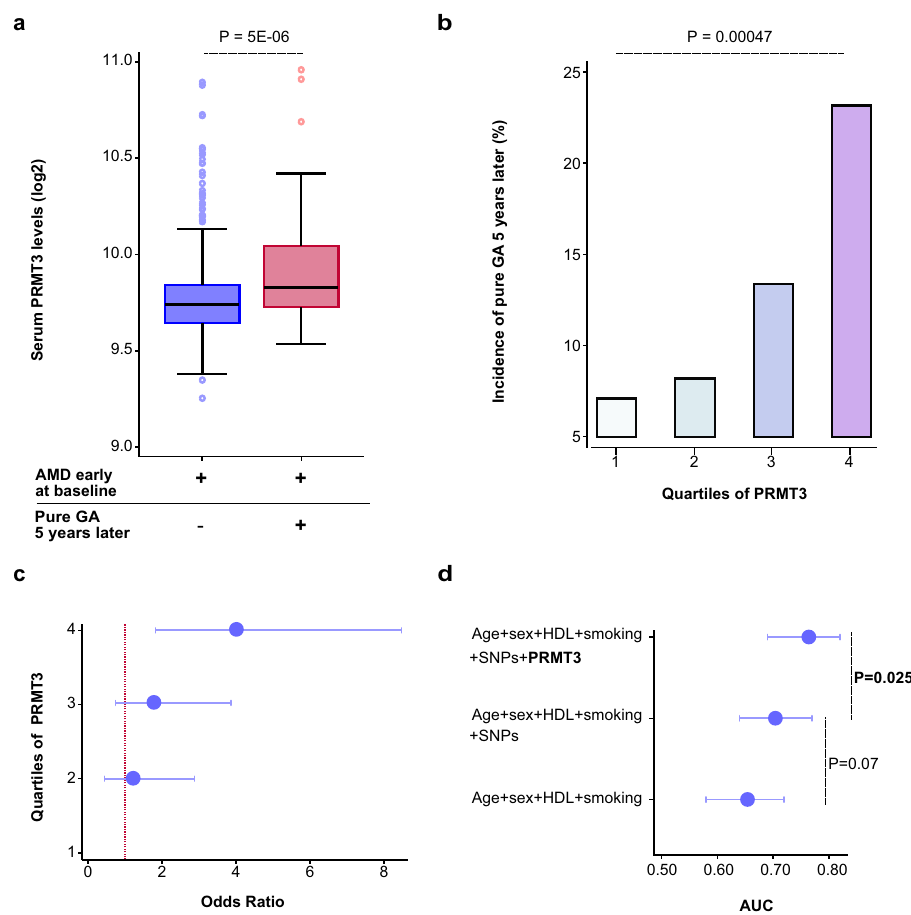
Fig. 3 PRMT3 is a novel biomarker for the progression of geographic atrophy. a Boxplot depicting the distribution of PRMT3 by progression status on a log2 scale. The blue box represents individuals ( n = 428) who had early-stage AMD (de fi nition by Jonasson et al. 23 ) at baseline and after a fi ve-year follow-up, while the red box represents subjects ( n = 62) who progressed from early-stage AMD to pure GA. The boxplot indicates median value, 25th and 75th percentiles. Whiskers extend to smallest/largest value no further than 1.5× interquartile range with outliers being shown. The highlighted P -value is two-sided, obtained from age and sex-adjusted logistic regression analysis. b The observed percentage incidence of pure GA at fi ve-year follow-up ( y -axis), as represented by PRMT3 quartiles ( x -axis), was assessed using an age and sex-adjusted logistic model. The P -value shown is two-sided. c Age and sex- adjusted odds ratios (OR) from a logistic regression model for progression to pure GA after a fi ve-year follow-up by PRMT3 quartiles (1st quartile as reference) (F-test P = 0.001, two-sided). The error bars for the mean OR (center) are the 95% CIs. d Area under the curve (AUC) comparison for various logistic models with incident pure GA as the outcome variable and various predictors such as age, HDL cholesterol (HDL), smoking (current), AMD genetic risk variants (single-nucleotide polymorphisms; SNPs) at chromosomes 1 (rs10922109 and rs570618) and 10 (rs3750846), and PRMT3. The error bars for the mean AUC (center) are the 95% CIs. The highlighted P -values are